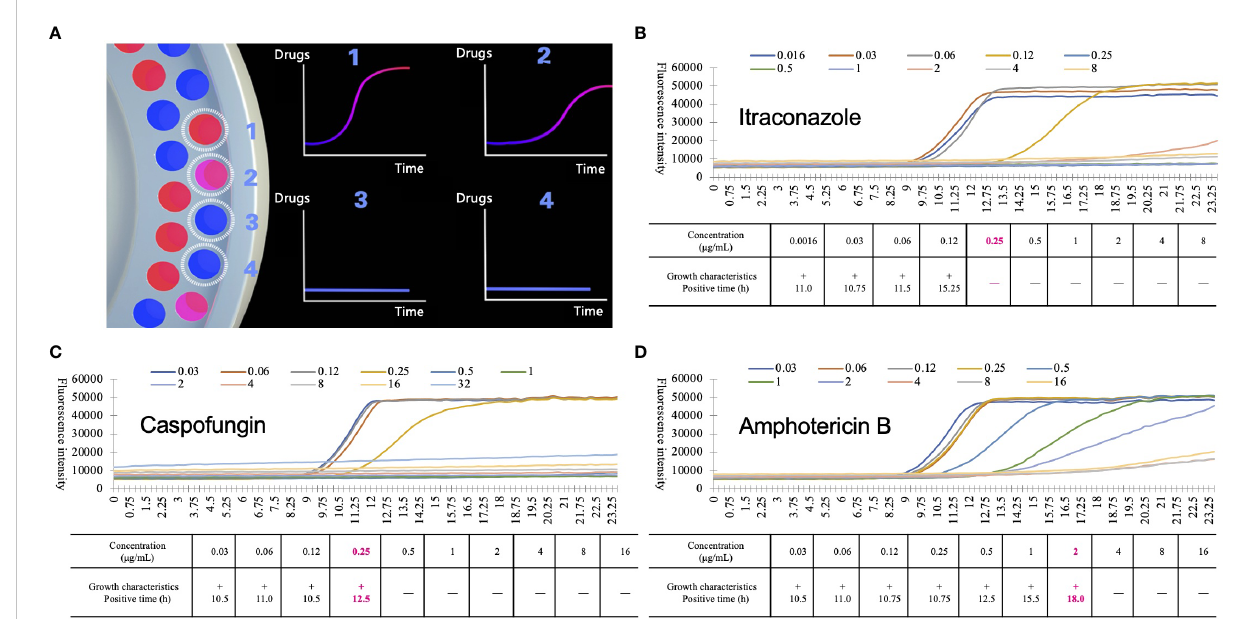
FIGURE 2 Detection principle of automated antimicrobial susceptibility testing system, Droplet 48 (D48). (A) the working mode diagram of D48: D48 monitors the fl uorescence of microdilution wells containing different concentrations of antifungal agents in real-time and fi ts the growth characteristics of the strains by the fl uorescence intensity over time. If the concentration of antifungal agents was higher than the minimum inhibitory concentration (MIC) of the tested strains (No.3 and No.4), the growth characteristics of the strains changed signi fi cantly compared to the microdilution wells containing lower MICs (No.1 and No.2, No.2 grows slightly slower than No.1); (B-D) growth characteristics of Candida krusei under different concentrations of itraconazole (B) , caspofungin (C) and amphotericin B (D) . During D48 testing, some substances will interfere with the fl uorescence signal. Based on